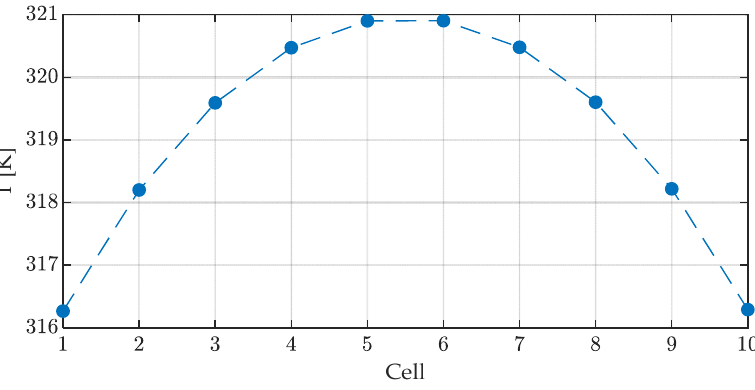
Figure 25. Simulated inner cell temperature ( T 1 ) at steady state.